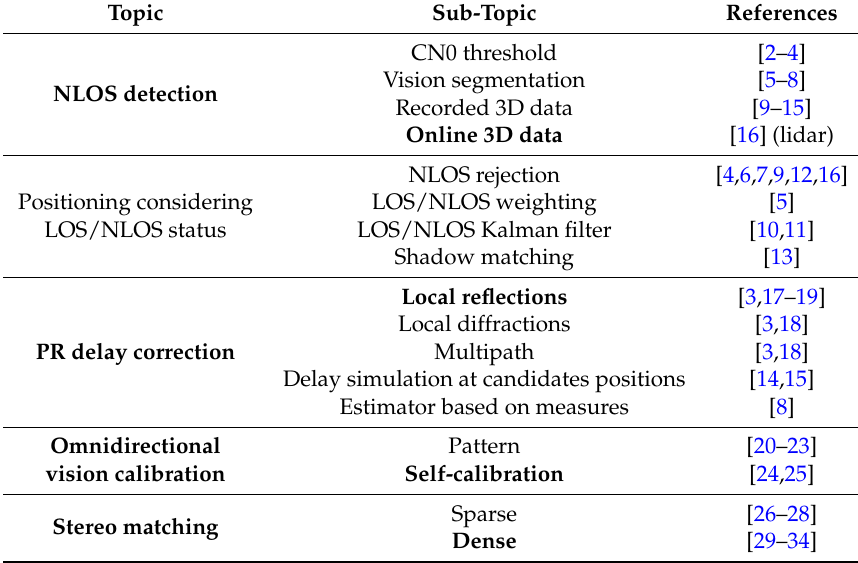
Table 1. Related works summary. Bold topics represent selected solutions for proposed